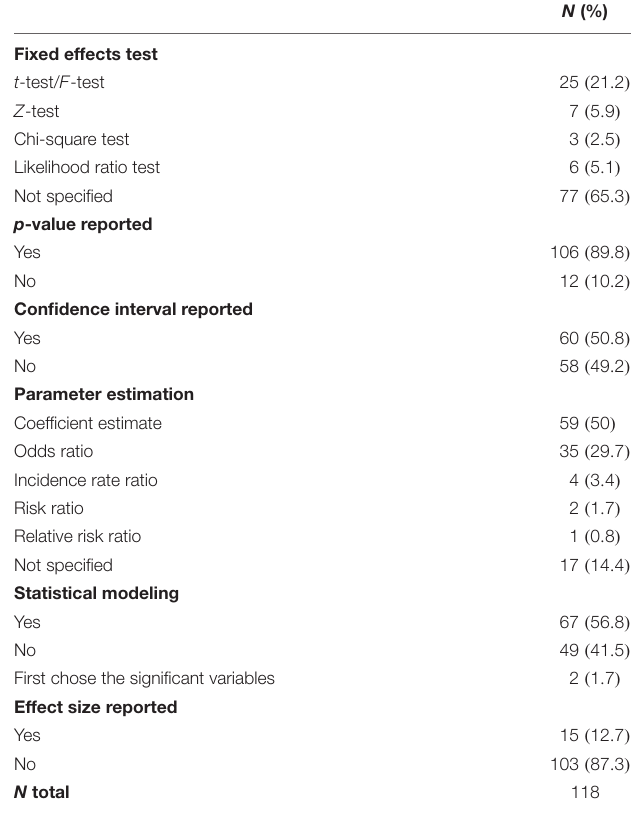
TABLE 3 | Characteristics of estimation methods, link function, and goodness-of-fit methods used in the 118 GLMM analyses.